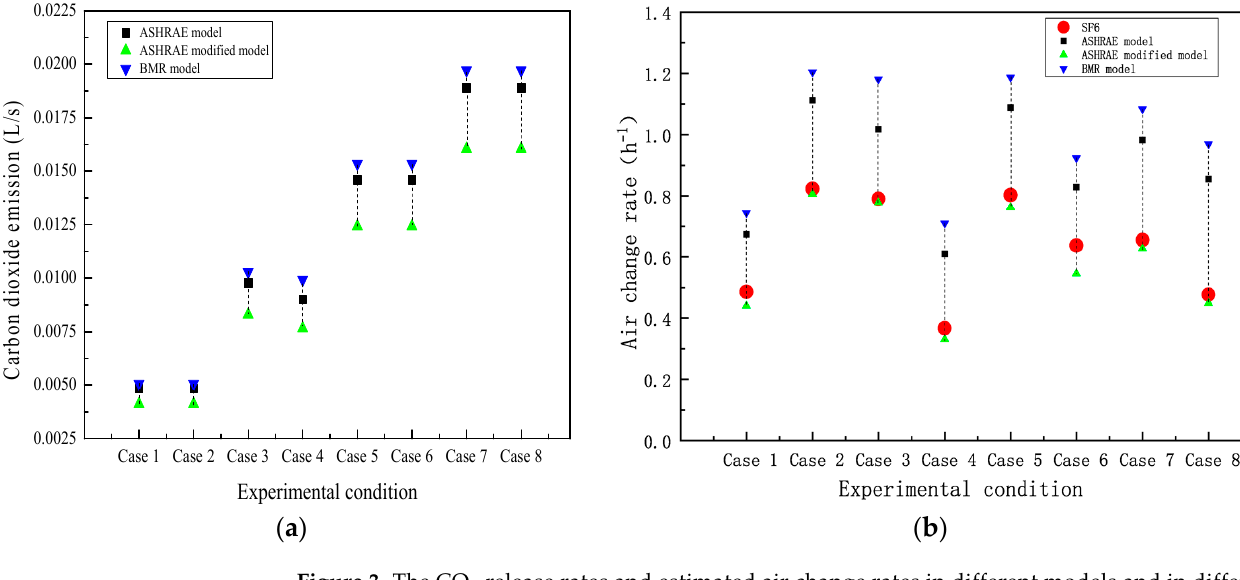
Figure 3. The CO 2 release rates and estimated air change rates in different models and in different experimental conditions (M = 65 W/m 2 , PMR = 1.45). ( a ) CO 2 release rate; ( b ) estimated air exchange rate